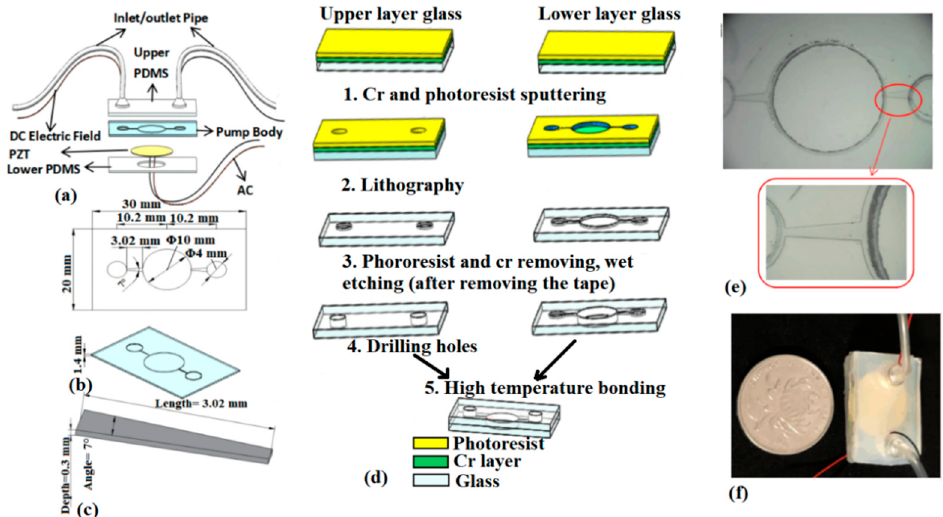
Figure 3. Structural design and manufacture of the micropump with glass wafer. ( a ) 3D structure of the micropump with PZT / LC combined driving. ( b ) The dimensions of the pump body. ( c ) The dimension of the microchannel. ( d ) The fabrication process of the microchannels and chambers by wet etching on glass wafer. ( e ) The microphotograph of the microchannel and pump chambers after wet etching. ( f ) The photograph of the micropump after